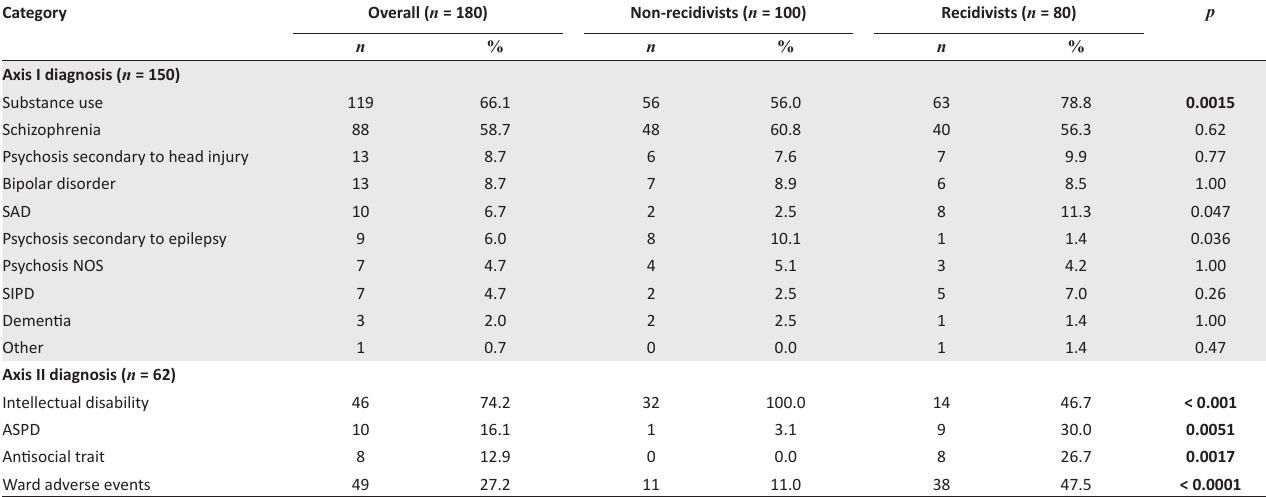
FIGURE 1: Sampling. TABLE 1: Clinical variables – Comparison between recidivists and